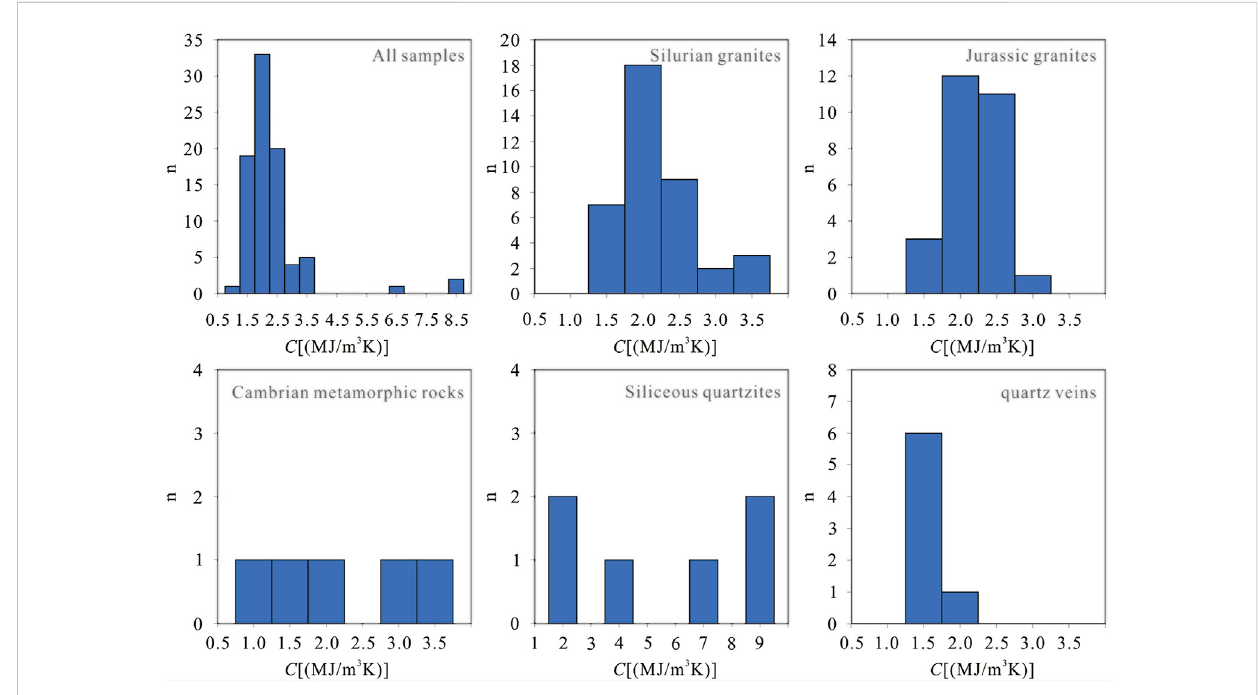
FIGURE 7 Superposition diagram of the geothermal geological map with speci fi c heat capacity